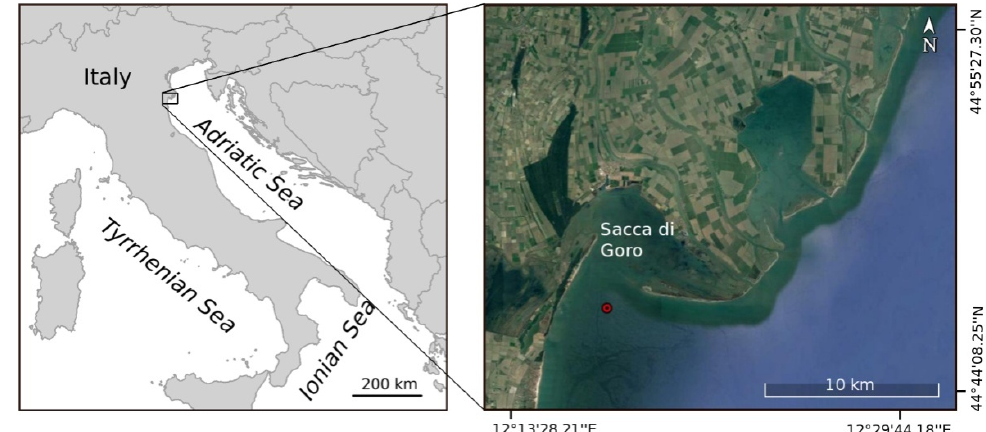
Figure 1. Map of sampling site. Sampling site marked with a red dot. Three samples, of five oysters each, were collected manually from three random sites along the long line and placed in plastic containers filled with sea water. In the laboratory, oysters were first rinsed with running water on a 0.5 mm mesh size sieve, in order to separate vagile epibiontic organisms for later taxonomic analyses, and then transferred to 90% ethanol. Each oyster was opened, the soft flesh was removed, and the length